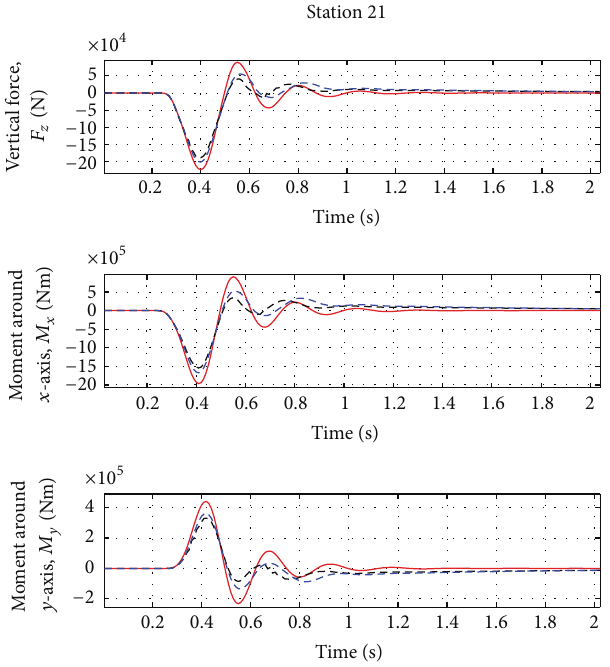
Figure 5: Wing loads for the nominal case with ideal and real actuator. Red solid line: open loop. Black dotted line: ideal actuator model. Blue dotted line: real actuator model.